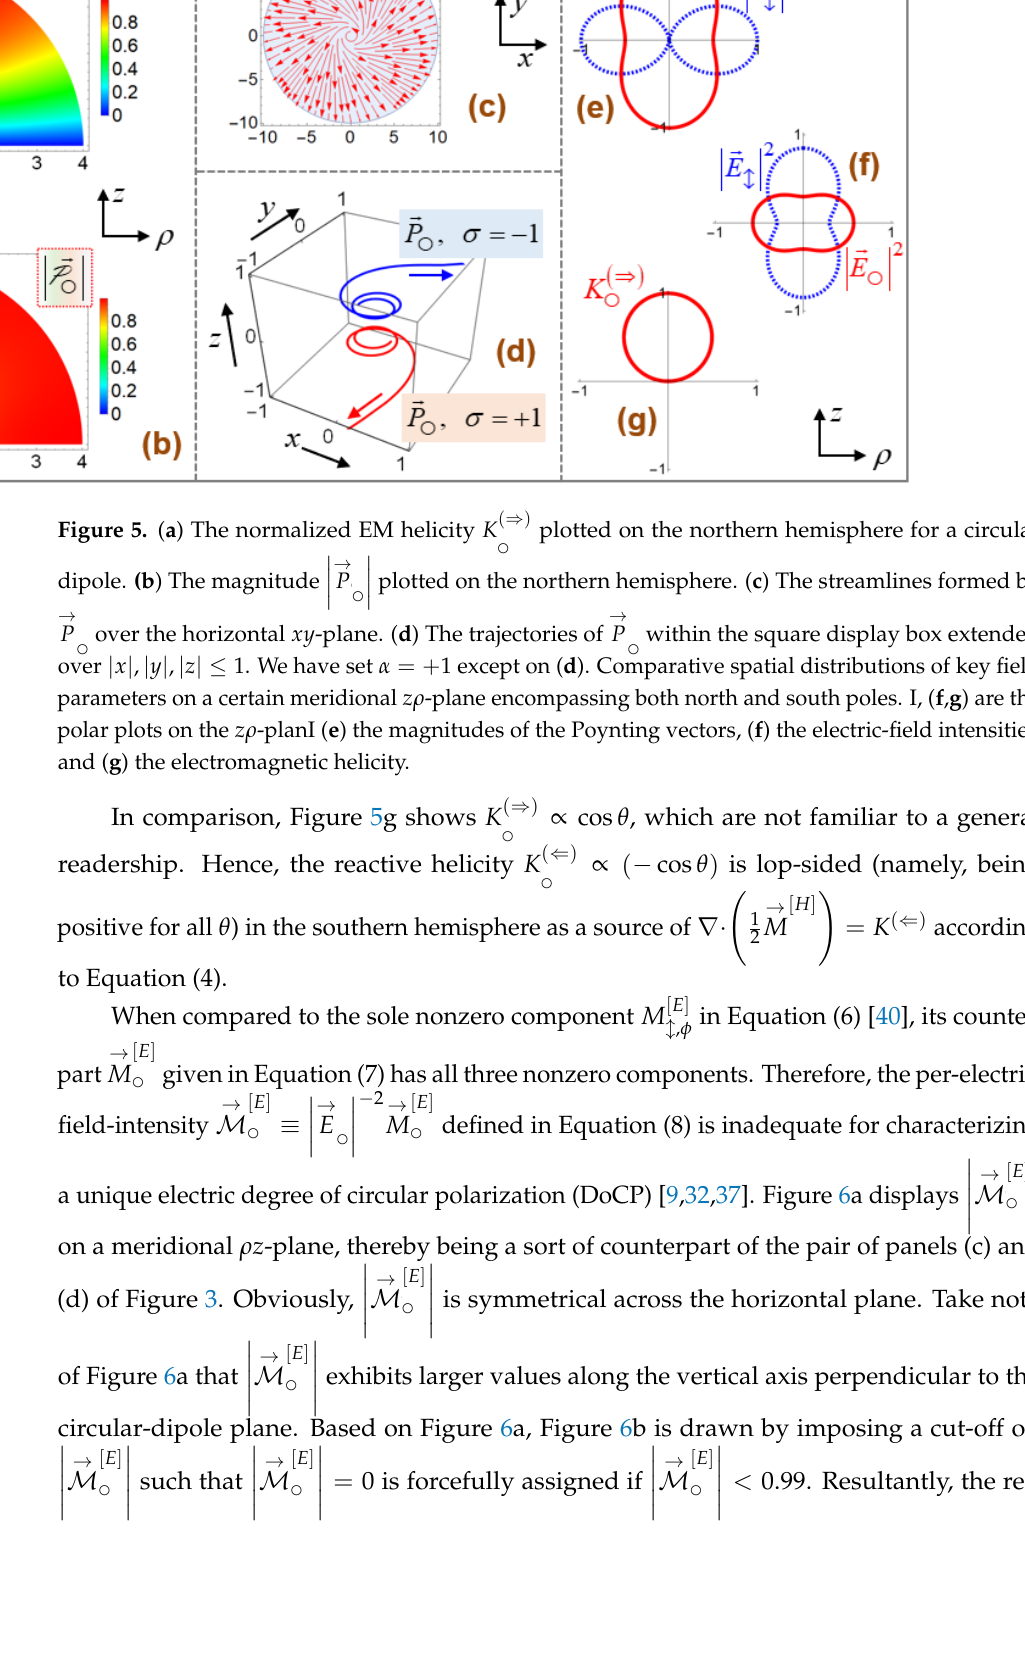
Figure 1. ( a ) Decomposition of a Poynting vector P   energy flux S . Besides, M is a spin angular momentum (SAM) density. ( b ) The coordinate systems. On the origin lies a primary electric point dipole represented by its unit vector ˆ p . ( c ) A linear dipole ˆ p with its dipole axis lying parallel to the vertical axis leads to a pencil-hull-like  tapered cylindrical surface designating higher values for the degree of circular polarization (DoCP). with its dipole axis lying on the horizontal plane leads to a filled solid ( d ) A circular dipole ˆ p  ○ cone of higher values of DoCP. 